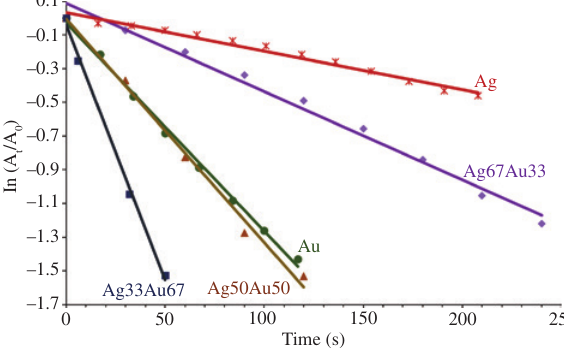
/ A ) vs. reaction time ( t t 0